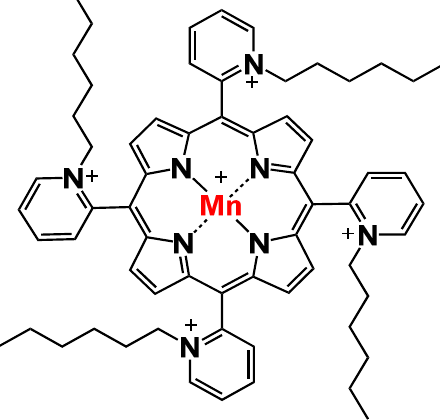
Figure 1. Chemical structure of MnTnHex-2-PyP 5+ (chemical name: Mn(III) meso -tetrakis( N -n-hexylpyridinium-2-yl)porphyrin), designated as MnTnHex throughout the text for simplicity.